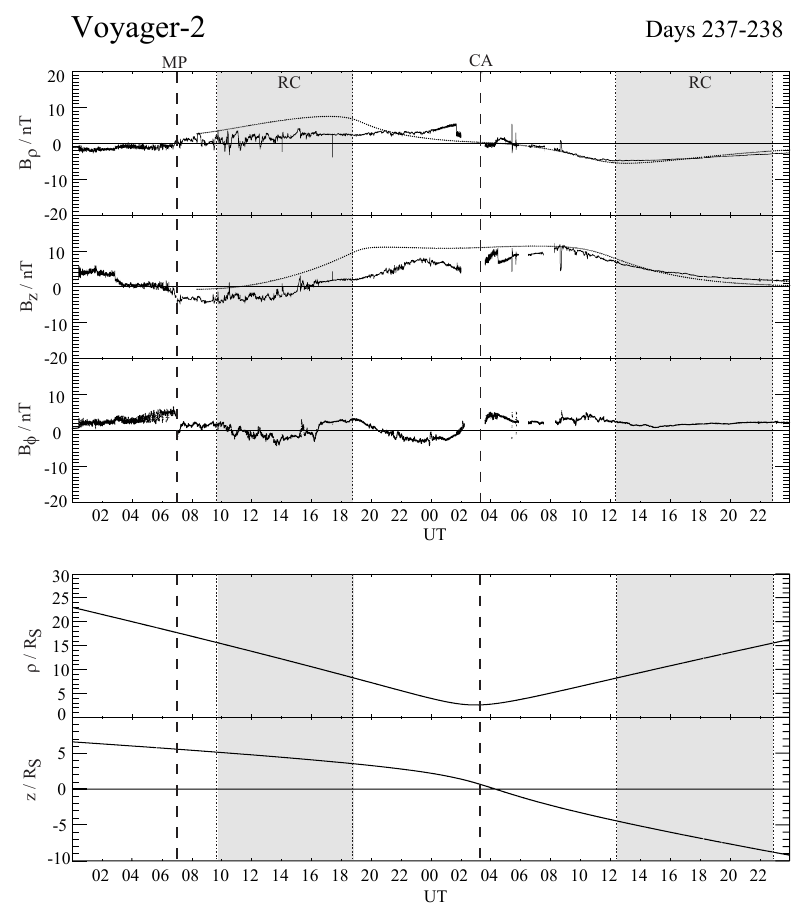
Figure 4 Fig. 4. Plot showing magnetic field and position data for the Voyager-2 fly-by of Saturn, in the same format as Fig. 3. Data for two (Earth) days are again shown, corresponding to days 237 and 238 of 1981. The fitted ring current model is again that derived by Connerney et al. (1983). In this case only one magnetopause crossing took place inbound at a spherical radial distance of 19 R S , and the closest approach occurred at a spherical radial distance of 2.7 R S